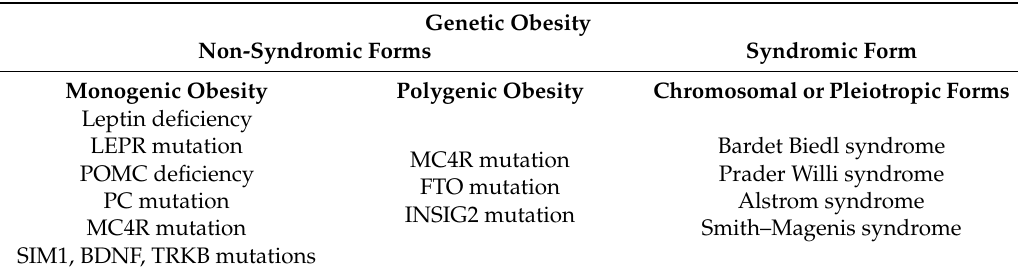
Table 1. Obesity induced by genetic